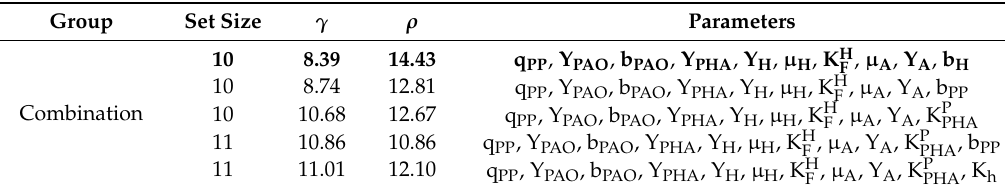
Table 2. Collinearity index ( γ ) and ( ρ ) of selected parameters subsets. Based on their function, the parameters are categorized into different process groups, i.e., physical, anaerobic, algal activity, autotrophic, and heterotrophic processes. The subset in bold is selected for parameter estimation based on values of γ and ρ .